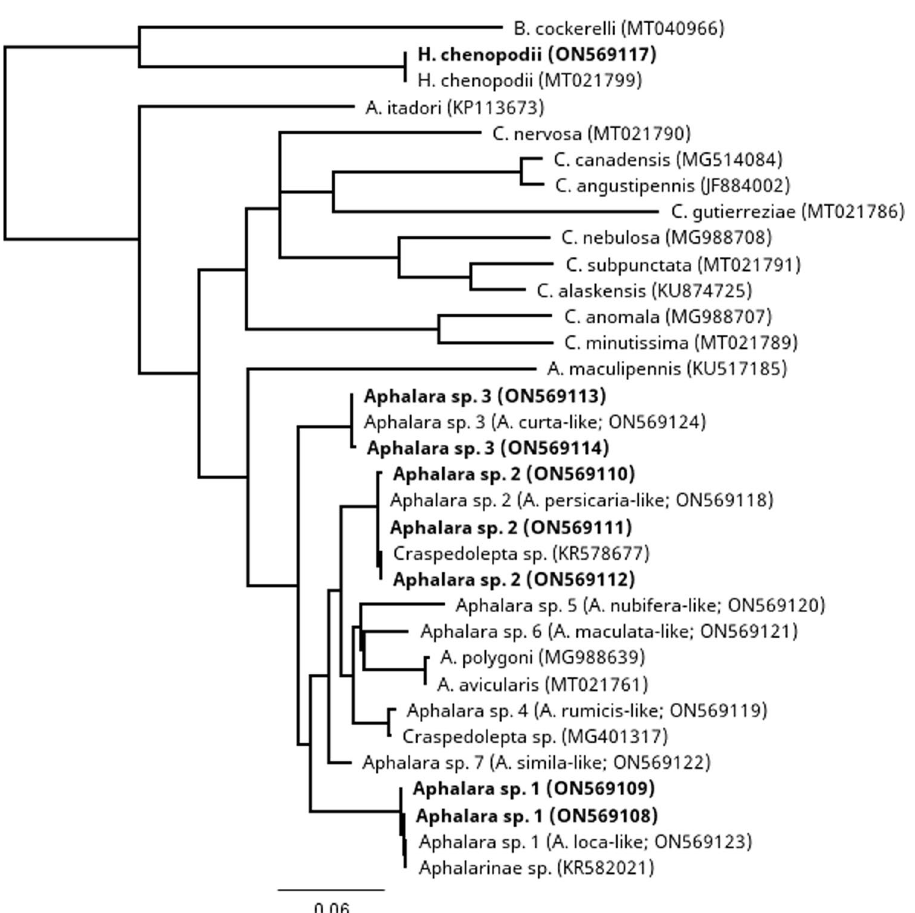
Figure 4. Unrooted phylogenetic tree constructed using a region of the mitochondrial cytochrome oxidase I gene ranging from 441- to 709-basepairs from Aphalara species, Craspedolepta species, Heterotrioza chenopodii , Bactericera cockerelli, the unknown specimens used in this study, and the specimens identified in the taxonomic study from collections made in the Pacific Northwest U.S. GenBank accession numbers are indicated in parentheses and ‘ Ca. L. solanacearum’-infected specimens from Klamath Basin are indicated in bold font. Bar length represents substitutions per